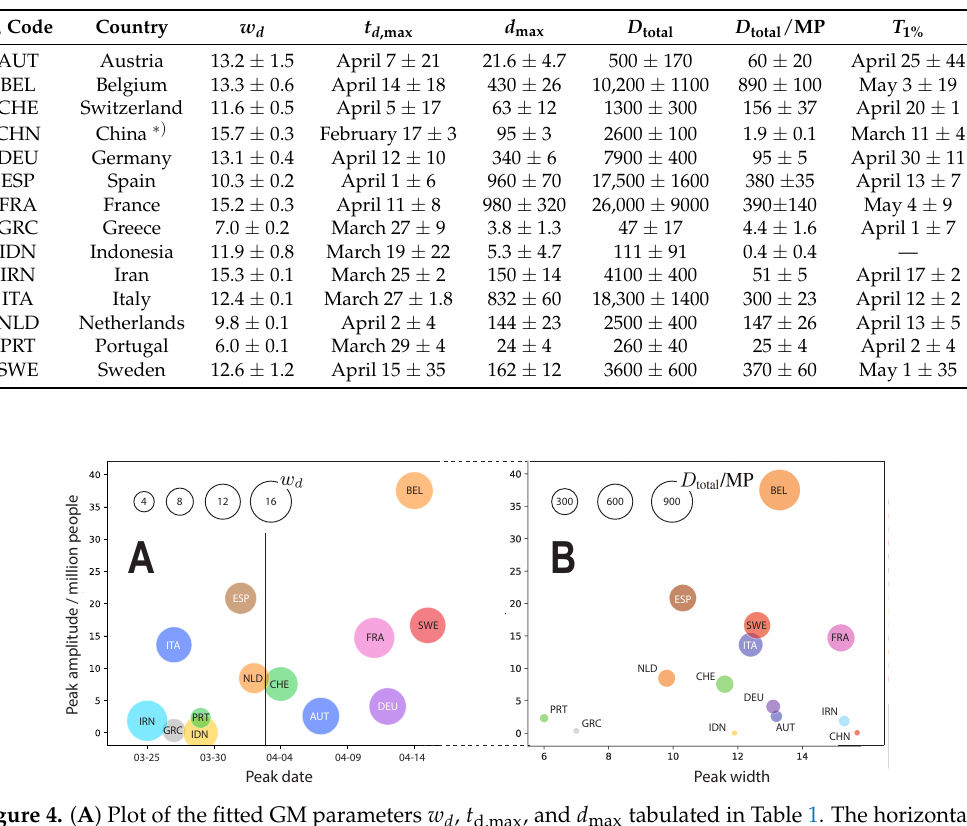
Table 1. Fitted GM parameters w d , t d,max , and d max for those countries, for which sufficient data about fatalities is available by the time of writing. Error bars reported for 95% confidence intervals. The table lists the three fitted GM parameters (width, time of peak, and peak value), followed by estimated cumulative number of fatalities D total , D total per million people (MP), and the predicted dates T η from Equation (A10) at which the number of daily infected people had reduced to the level of η of its maximum value. Number of inhabitants according to OECD [29]. For a plot of the fitted parameters see Figure 4. ∗ ) For China we considered only the data during the first pandemic wave, i.e., until a minimum in daily fatalities was reached on March 12.